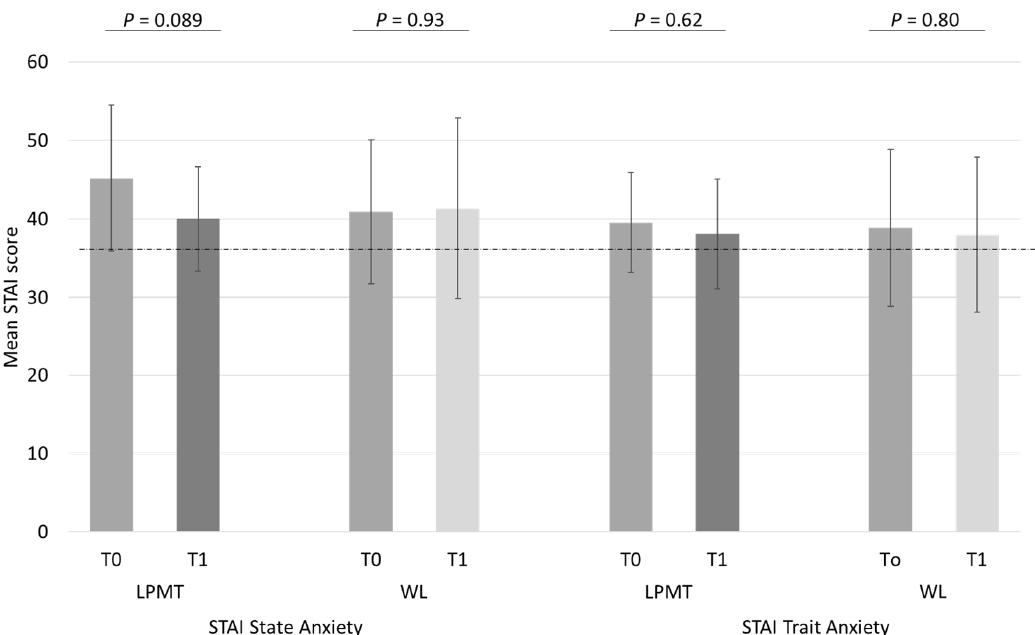
Figure 4. Differences in state and trait anxiety before (T0) and after (T1) either LPMT or waitlist periods. STAI—State and Trait Anxiety Inventory; LPMT—Live-Performed Music Therapy; WL—waitlist. Dotted line represents the norm score of 35 according to the reference population of working women aged 19–39, i.e., 36.17 for state and 36.15 for trait anxiety.